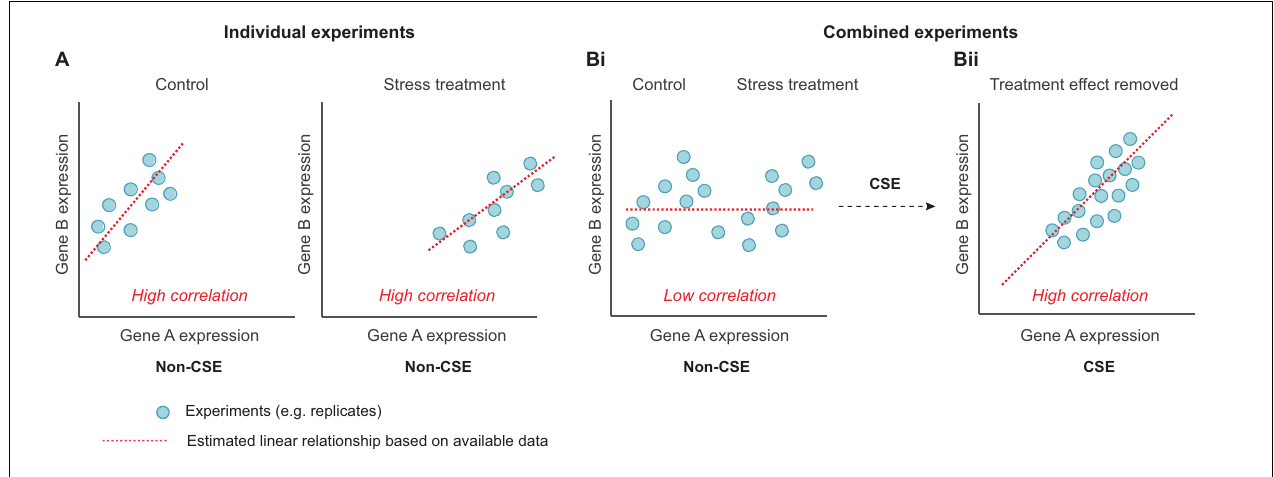
FIGURE 1 | Schematic illustrating the utility of centralization within sub-experiments (CSE) when comparing genes from a diverse background of treatments. (A) Conventional correlation analysis of two genes (Gene A and Gene B) under control conditions reveals a high positive correlation. Corresponding correlation analysis of the same two genes in response to a stress treatment again reveals a high positive correlation. (Bi) When both the control and stress experiments are combined, conventional correlation analysis results in a low level of correlation (false negative). (Bii) By carrying out CSE, the mean effect between replicates is removed, and subsequent conventional correlation analysis now reveals the “core” high correlation between Gene A and Gene B.